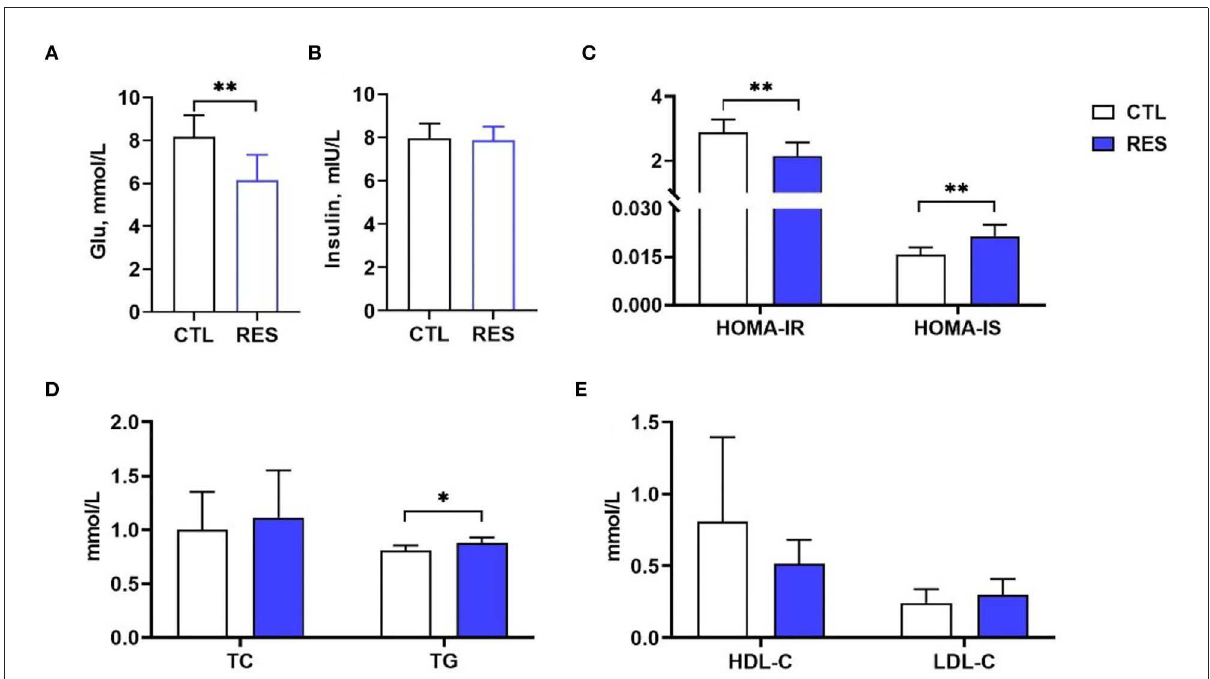
FIGURE1 The effect of RES on glucose metabolism and lipid metabolism in perinatal sows. (A) Glu, (B) insulin, (C) HOMA-IR and HOMA-IS, (D) TC and TG, and (E) HDL-C and LDL-C. Glu, glucose; HOMA-IR, homeostasis model assessment-insulin resistance; HOMA-IS, homeostasis model assessment-insulin sensitivity; TC, total cholesterol; TG, triglycerides; HDL-C, high-density lipoprotein cholesterol; LDL-C, low-density lipoprotein cholesterol; CTL, a basal diet; and RES, a basal diet containing 200 mg/kg resveratrol. Data are expressed as mean ± SD ( n = 10); *, p < 0.05; and **, p < 0.01.